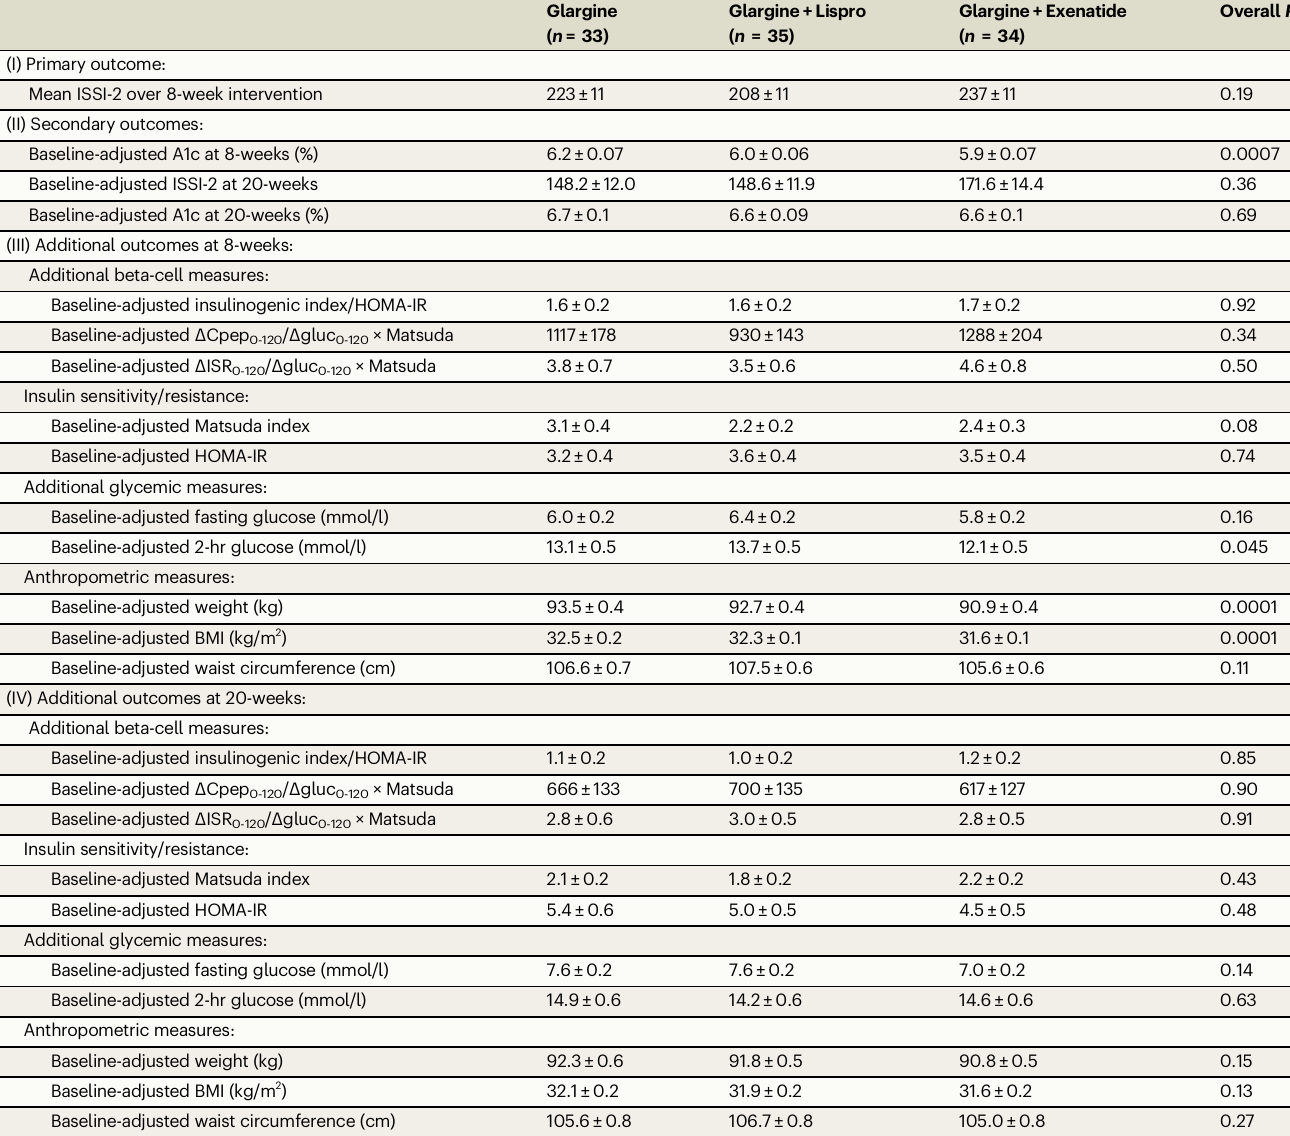
Table 2 | Primary, secondary and additional outcomes at 8-weeks and 20-weeks Glargine Glargine+Lispro Glargine+Exenatide Overall